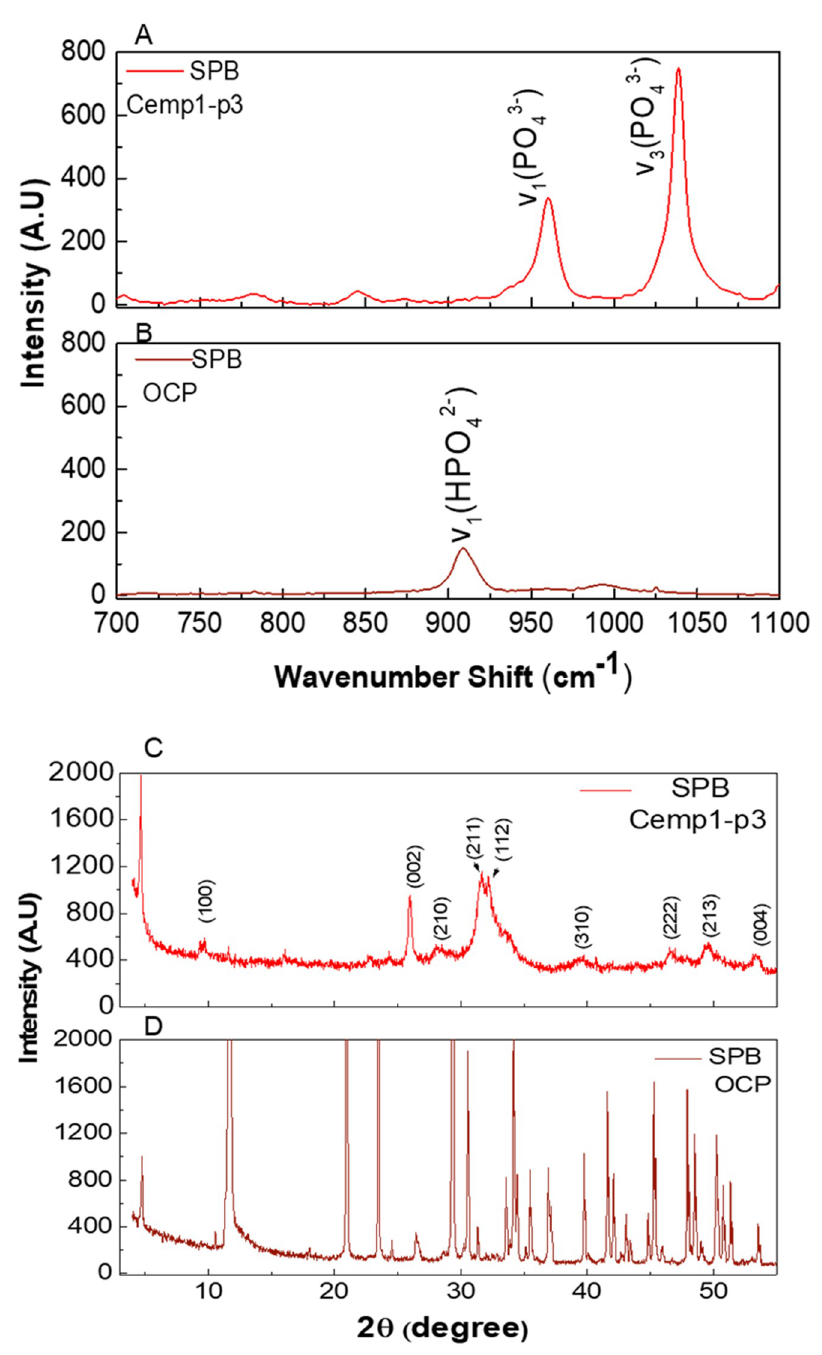
Figure 8. Raman spectra and XRD patterns of control and experimental samples obtained after SPB assay. ( A ) Raman spectra corresponds to HA bands (experimental), ( B ) Raman spectra corresponds to the OCP bands (control), ( C ). HA crystalline phase (experimental) and ( D ) Reflections of the crystalline planes of OCP (control). (SPB = simulated physiological buffer).